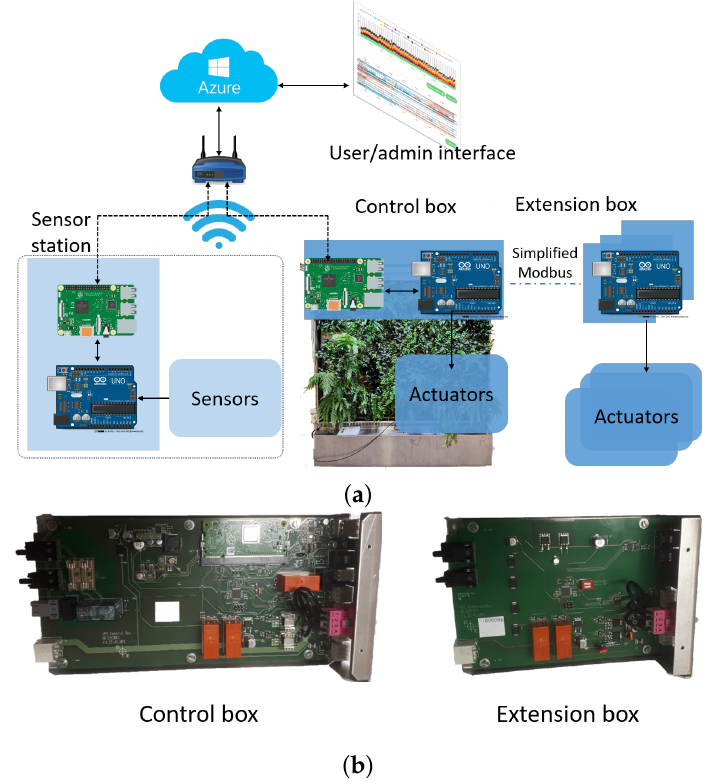
Figure 7. ( a ) The initial digital solution is partitioned into sensor station, control-box, and extension- box. ( b ) The final hardware implementation of control-box and extension-box for vertical plant